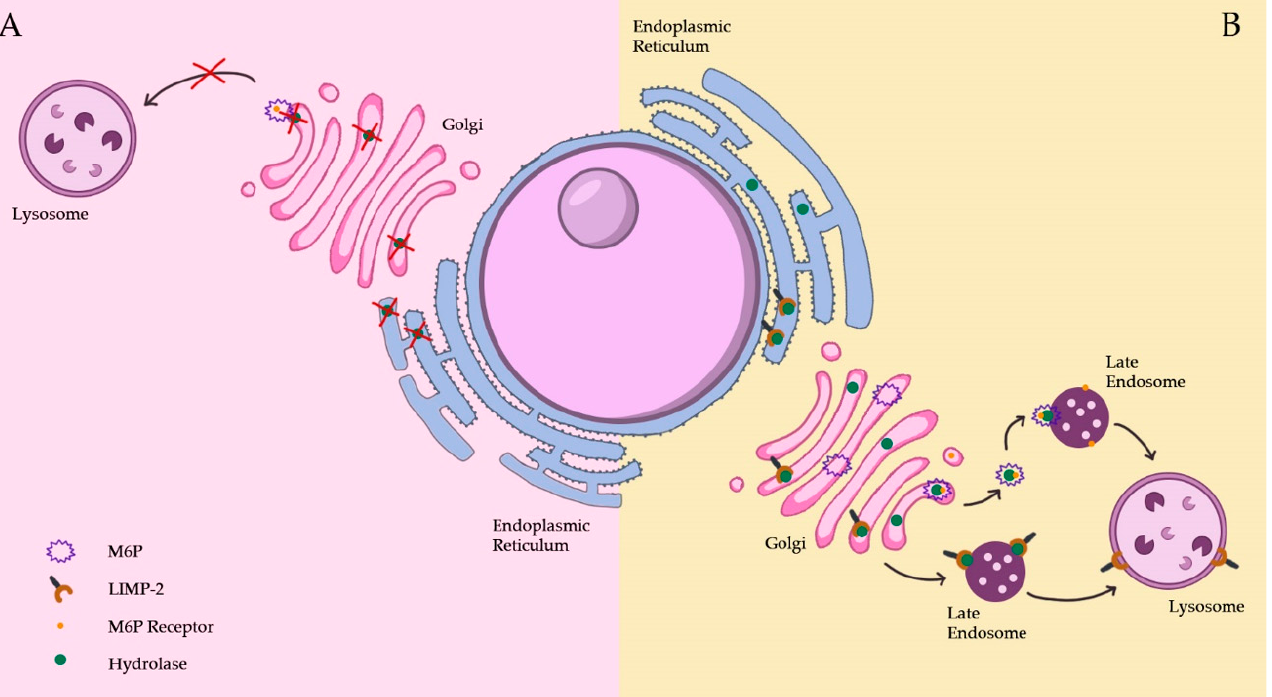
Figure 2. Examples of lysosomal hydrolase deficiency. In (A), the mutated hydrolase is not able to pair with the transporter and consequently is not able to reach the lysosome. In (B), the mutated hydrolase is carried to the lysosome through the M6P pathway or through the LIMP-2 pathway but is not able to degrade, leading to substrate accumulation in the lysosome.